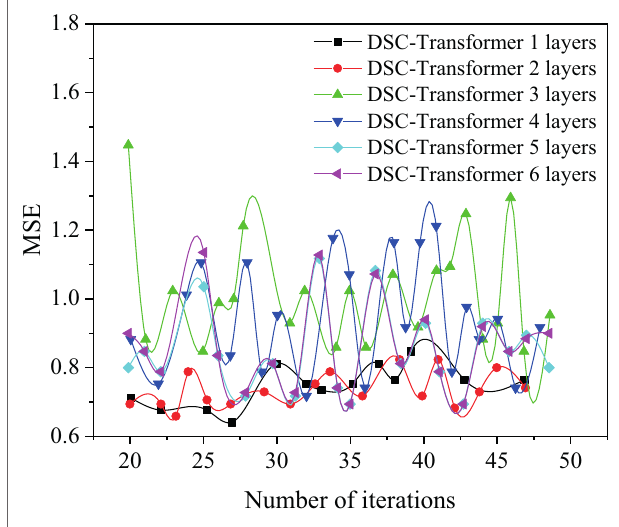
FIGURE 6 | The mean square error (MSE) value of the DSC-Transformer structure with different layers used in the prediction